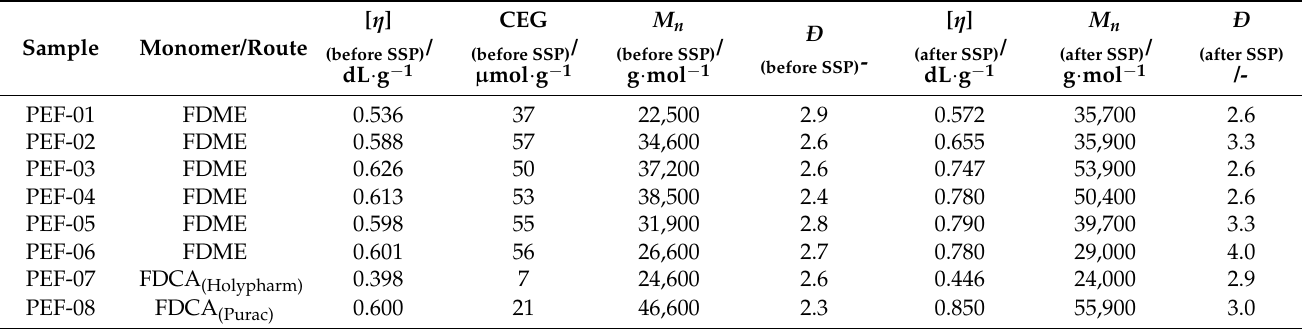
Table 1. Summary of [ η ], number of carboxylic end groups (CEGs), M n (number average of molar mass) and Ð (dispersity) of the synthesized PEF before and after (SSP); sample-nomenclature refers to the experimental order within the